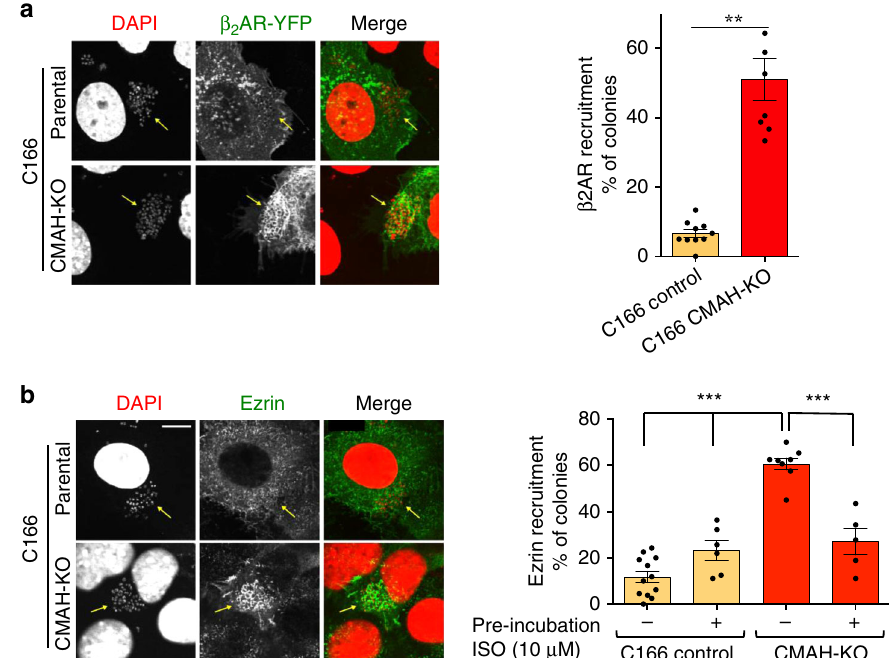
Fig. 5 Terminal Neu5Ac contributes to meningococcus species speci fi city. a A CMAH -KO clone, in which endogenous CMAH was mutated on both alleles (causing reading frame shift) using a CRISPR/Cas9 approach (Supplementary Fig. 8), was derived from C166 mouse endothelial cells. Wild-type or CMAH- KO C166 cells expressing exogenous YFP-tagged human β 2 AR and CEACAM-1 (to induce mock bacterial adhesion) were infected with piliated non- capsulated Opa + (2C43 SiaD- Opa + ) meningococci. Receptor distribution was examined by fl uorescence microscopy. Receptor accumulated under bacterial colonies (arrows) in CMAH-KO but not in wild-type cells, re fl ecting the requirement of Neu5Ac (instead of Neu5Gc) for pili interaction with the β µ m. Right panel: recruitment of β fi ed and expressed as the % of bacterial colonies that 2 AR. Left panel: representative images, bar: 10 2 AR was quanti recruited transfected β 2 AR-YFP. Mean values± SEM. Statistical signi fi cance was calculated by t test, ** p < 0.01. b To examine the reconstitution of a typical β 2 AR-dependent signaling pathway induced by meningococcus in the CMAH-KO C166 clone, cells were transfected with a plasmid encoding human CEACAM-1, pre-incubated or not with isoproterenol for 1 h (to induce the endocytosis of endogenous β 2 AR), and then exposed to piliated non-capsulated Opa + (2C43 SiaD − Opa + ) meningococci. Ezrin recruitment under colonies was used as a marker of β 2 AR signaling. *** P < 0.001 (ANOVA, n = 3 in duplicate). Representative images are shown in the left panel, bar: 10 µ